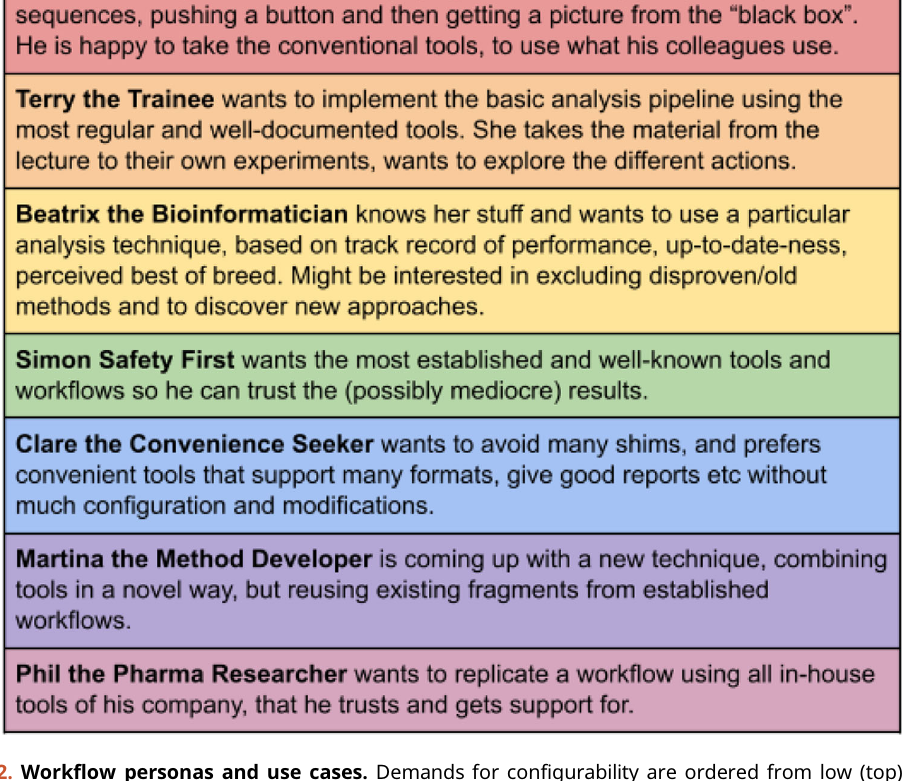
Figure 2. Workflow personas and use cases. Demands for configurability are ordered from low (top) to total (bottom). All participants need a publication-ready description of the provenance of their findings for perfect